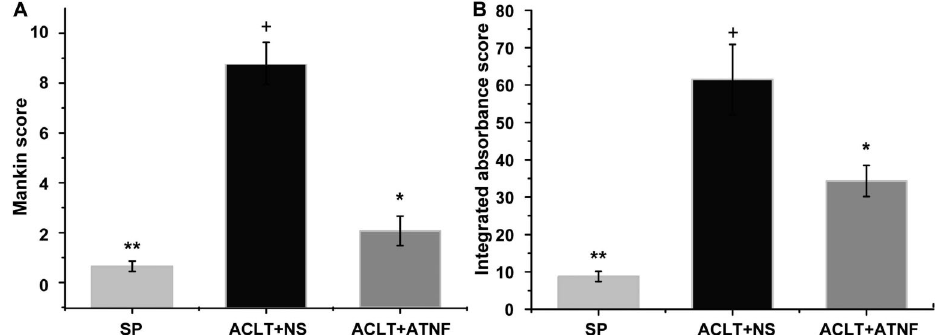
Figure 3. A, Mankin scores for grading of cartilage lesions. B, integrated absorbance values re fl ecting matrix metalloproteinase (MMP)- 13 expression. + P o 0.05, anterior cruciate ligament transection (ACLT) + normal saline (NS) group compared to the sham-operated (SP) group; *P o 0.05, ACLT + anti-tumor necrosis factor- a antibody (ATNF) group compared to the ACLT + NS group; **P o 0.05, SP group compared to the ACLT + ATNF group (Student ’ s t